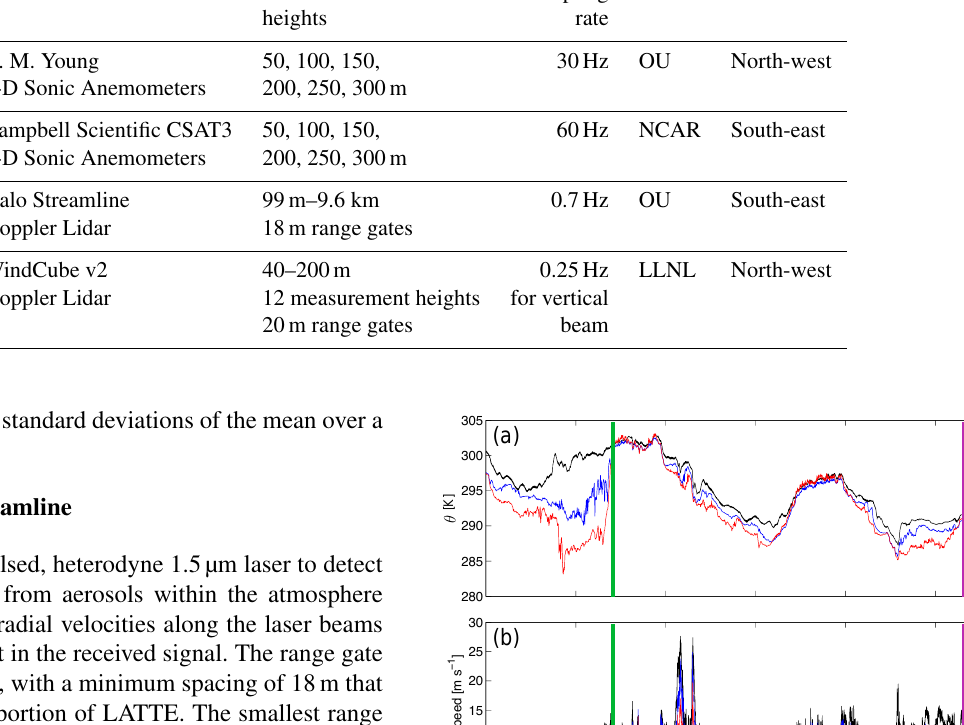
Table 1. Overview of all instruments and their properties. Instrument Measurement Sampling